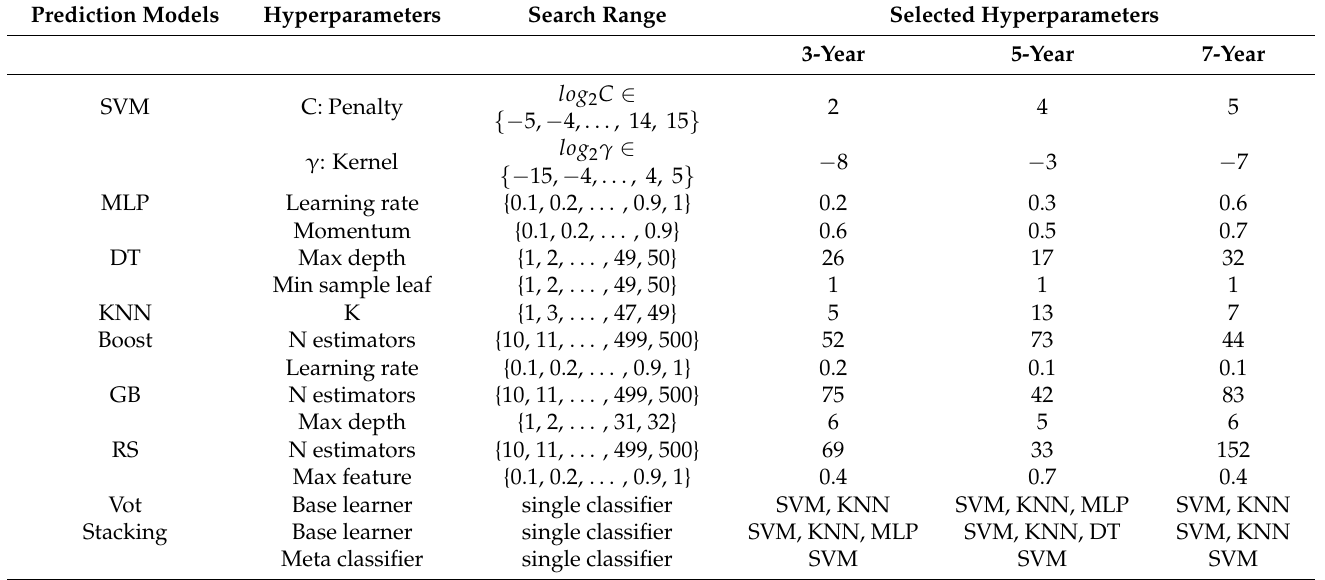
Table 4. Hyper-parameters of machine learning